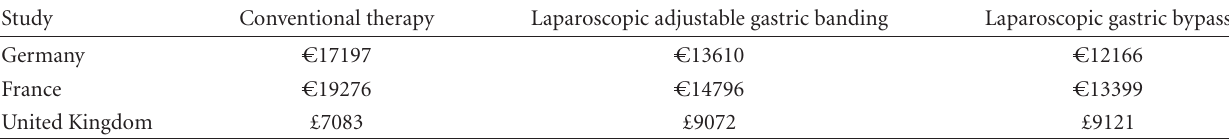
Table 1: Cumulative cost per patient over 5 years including cost of therapy, cost of complications, and cost of prevalent T2DM [11].